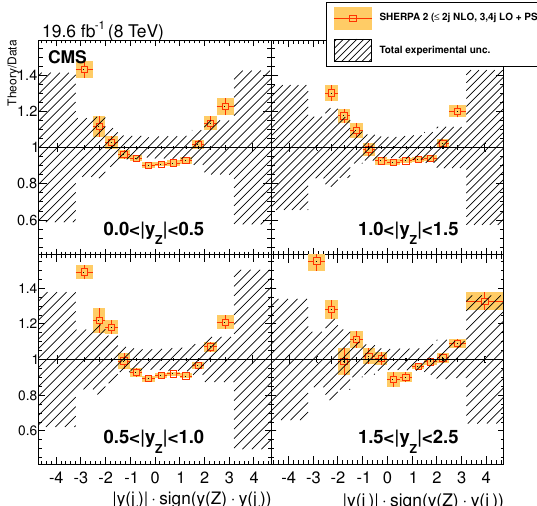
Figure 35 . Ratio to the measurement of the di(cid:11)erential cross section d 2 (cid:27)= d y (Z)d y (j with sherpa 2, with up to two jets at NLO and up to four jets at LO. The total experimental uncertainty is shown as a band around 1. Uncertainties in the predictions are shown on the ratio points and include the statistical uncertainty only.